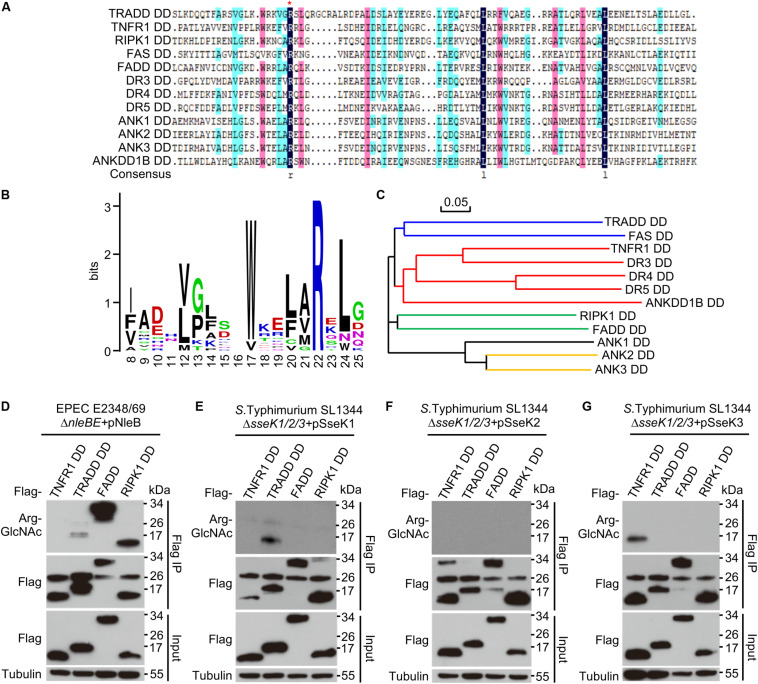
SseK1 and SseK3 selectively modify TRADD and TNFR1 during pathogen infection. (A) Multiple sequence alignment of 12 DD proteins from 34 human DD-containing proteins. The red asterisk indicates the conserved arginine. (B) Site distribution of amino acids in 12 conserved arginine containing-DDs. (C) Phylogenetic tree of the 12 DDs constructed on the basis of sequence similarity. (D–G) Selective GlcNAcylation of DDs by NleB and SseK1/2/3 during bacterial infection. 293T cells transfected with the indicated Flag-DD plasmids were infected with EPEC or Salmonella strains. Cell lysates were subjected to anti-Flag immunoprecipitation and immunoblotting. Data in (D–G) are from at least three independent experiments.